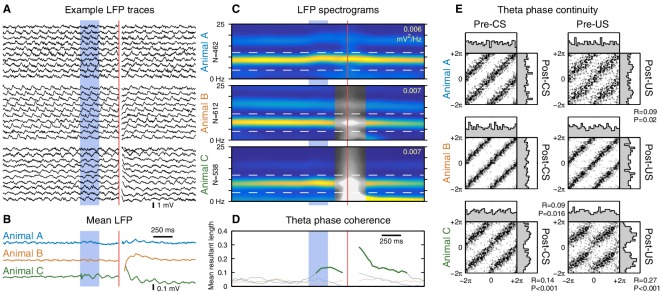
The CS does not reset ongoing hippocampal theta oscillations.This figure shows CS- and US-evoked changes to ongoing theta oscillations in the hippocampal local field potential (LFP) while running. (A) Randomly selected example LFP traces from each animal. Note that theta oscillations are prominent and consistent across trials. (B) Averaged hippocampal LFP. Theta-band oscillations are visible in animal C, but note the 10-fold reduction in scale compared to the raw LFPs. (C) LFP spectrograms. Note the strong theta power that persists throughout the trial. Horizontal dashed lines indicate the 4–12 Hz theta band, and the peak spectral power density is indicated in the top right of each spectrogram. Animals B and C exhibited high-amplitude transients following the US, and time windows that overlap this transient are shown in greyscale. (D) Mean resultant length, a measure of theta phase coherence across trials. Values that correspond to a significantly non-uniform phase distribution (p<0.01, Rayleigh test) are shown in bold. Animal C exhibits a sustained phase alignment that persists for several theta cycles, but the other two animals show no significant phase alignment at all. (E) Phase transition curves. Each scatterplot compares the theta phase before and after the stimulus (see Materials and methods and Figure 5—figure supplement 3); each dot is a single trial and two cycles are shown for clarity. A diagonal line (e.g. animal B) indicates that the theta rhythm is unaffected by the eyeblink stimuli, whereas a horizontal line would indicate theta reset to a fixed phase. Each scatterplot is accompanied by histograms of the phase distributions. The mean resultant length (R) and Rayleigh test P-value are reported for cases where P<0.05. Note that even in cases with a significant stimulus-evoked alignment of theta phase, the actual perturbation of ongoing theta oscillations is very subtle.